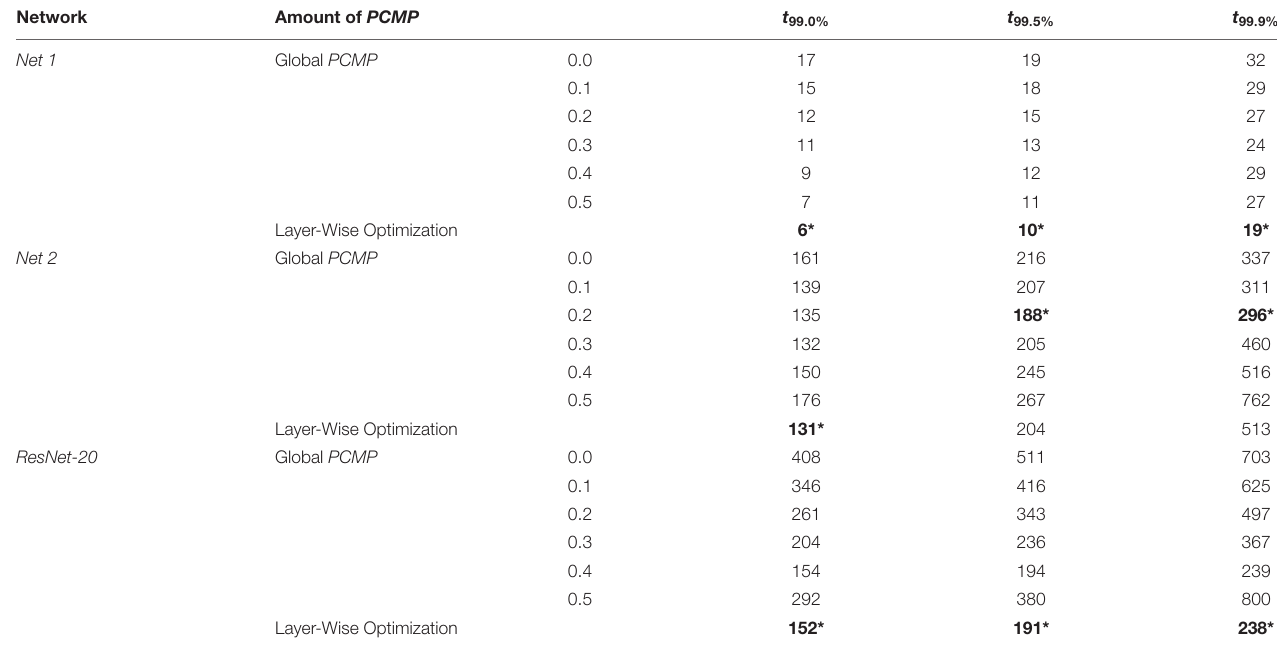
The best records in each network are marked in bold with *.